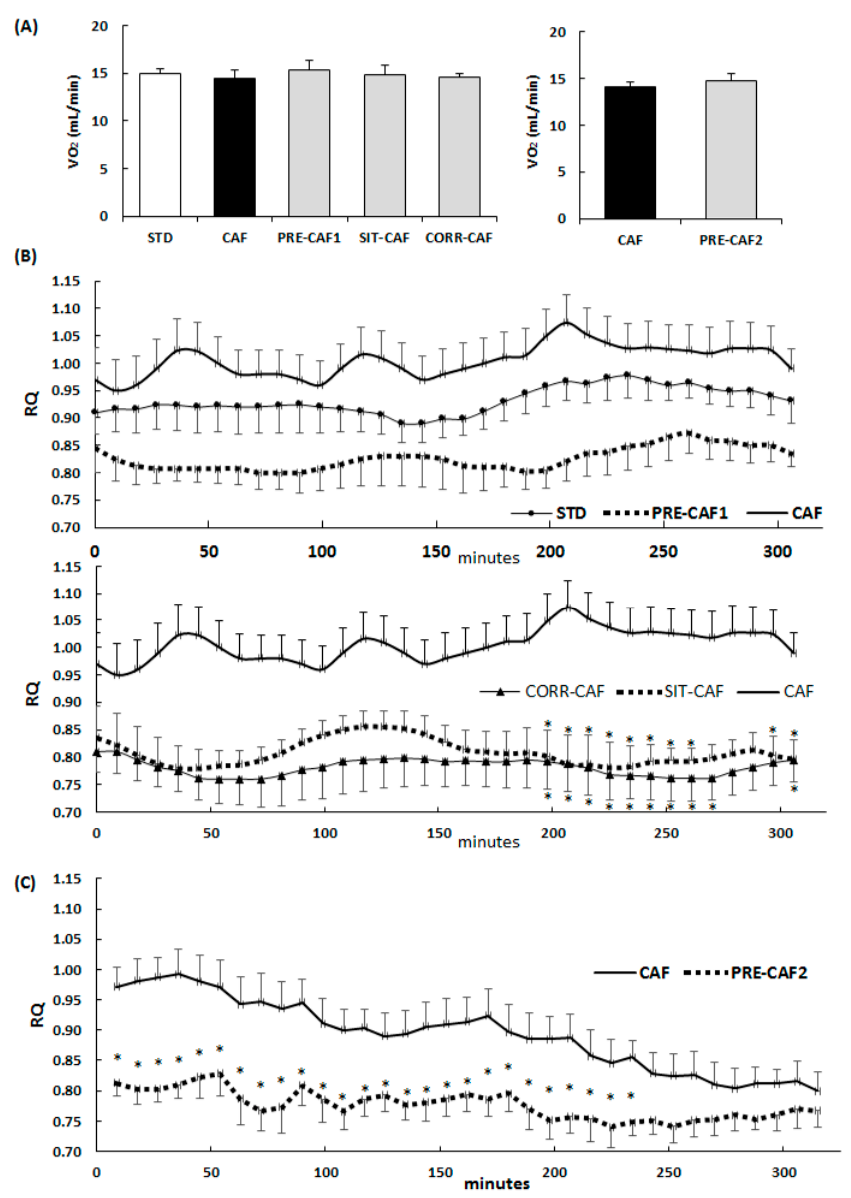
Figure 3. Patterns of energy expenditure and Respiratory Quotient (RQ) due to GSPE-treatments. Rats entered an indirect calorimeter for respiratory measurements at 08:00 am and remained until 02:00 p.m. Short-term challenge measurements were taken during the 7th week of the post-GSPE treatment ( n = 7 animals/ group). Long-term challenge measurements were taken on the first day of the 17th week of the cafeteria diet ( n = 6 animals/group). ( A ) Mean oxygen consumption measured (long-term challenge in the left panel and short-term challenge in the right panel); ( B ) Mean RQ measured in the long-term challenge (upper panel, effects due to PRE-CAF1 treatments; lower panel, effects on animals in SIT-CAF treatment); ( C ) Mean RQ measured in the short-term challenge for PRE-CAF2 treatment vs. CAF. STD: standard chow diet; CAF: cafeteria diet; PRE-CAF1: rats receiving GSPE preventive treatment 10 days before the cafeteria intervention started; PRE-CAF2: rats receiving GSPE preventive treatment for 10 days together with a high fat/high sucrose diet followed by a cafeteria diet intervention; SIT-CAF: rats receiving GSPE treatment simultaneously and intermittently with the cafeteria diet every other week; RQ: respiratory quotient. Values are means ± SEM. * p < 0.05 compared with CAF